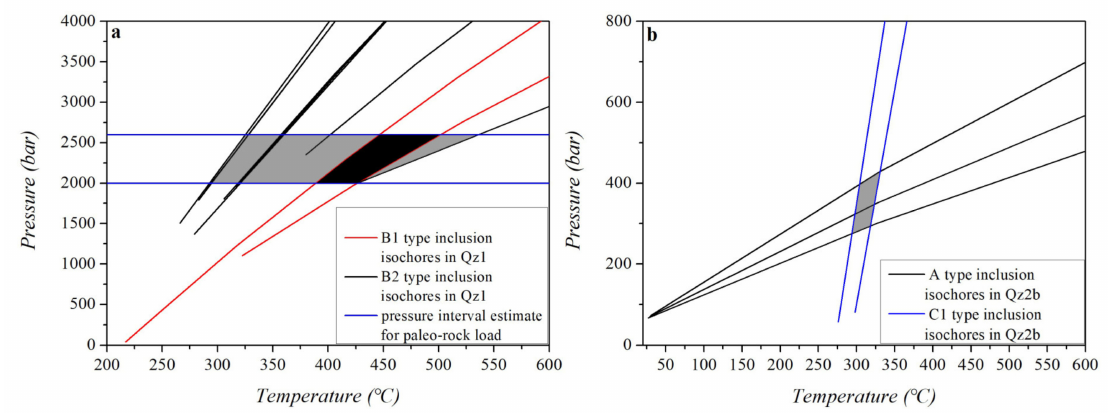
Figure 11. Estimated trapping pressures and temperatures by fluid inclusion isochores. ( a ) Interception betweenB-typeinclusionisochoresandpressureestimatedfrompaleo-rockloadforQz1; ( b) Interception between A- and C1-type inclusion isochores for